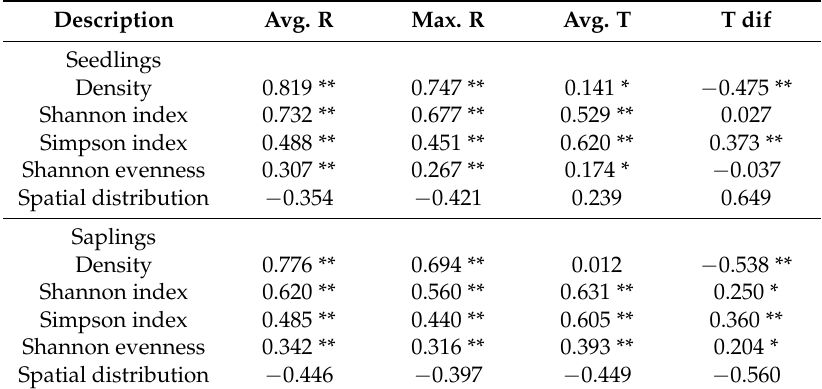
Table 8. Pearson correlation coefficients between forest growth and environmental factors.